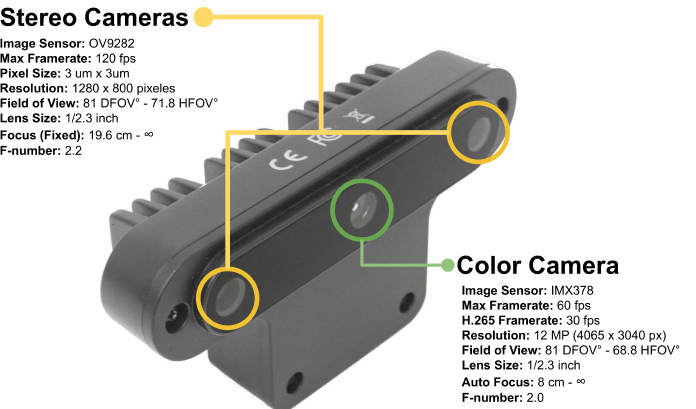
Figure 1. OAK-D is a camera capable of running neural networks simultaneously while providing depth from two stereo cameras and colour information from a single 4K camera in the centre. The camera’s weight is 117 g, and its dimensions are 110 mm in width, 54.5 mm in height, and 33 mm in